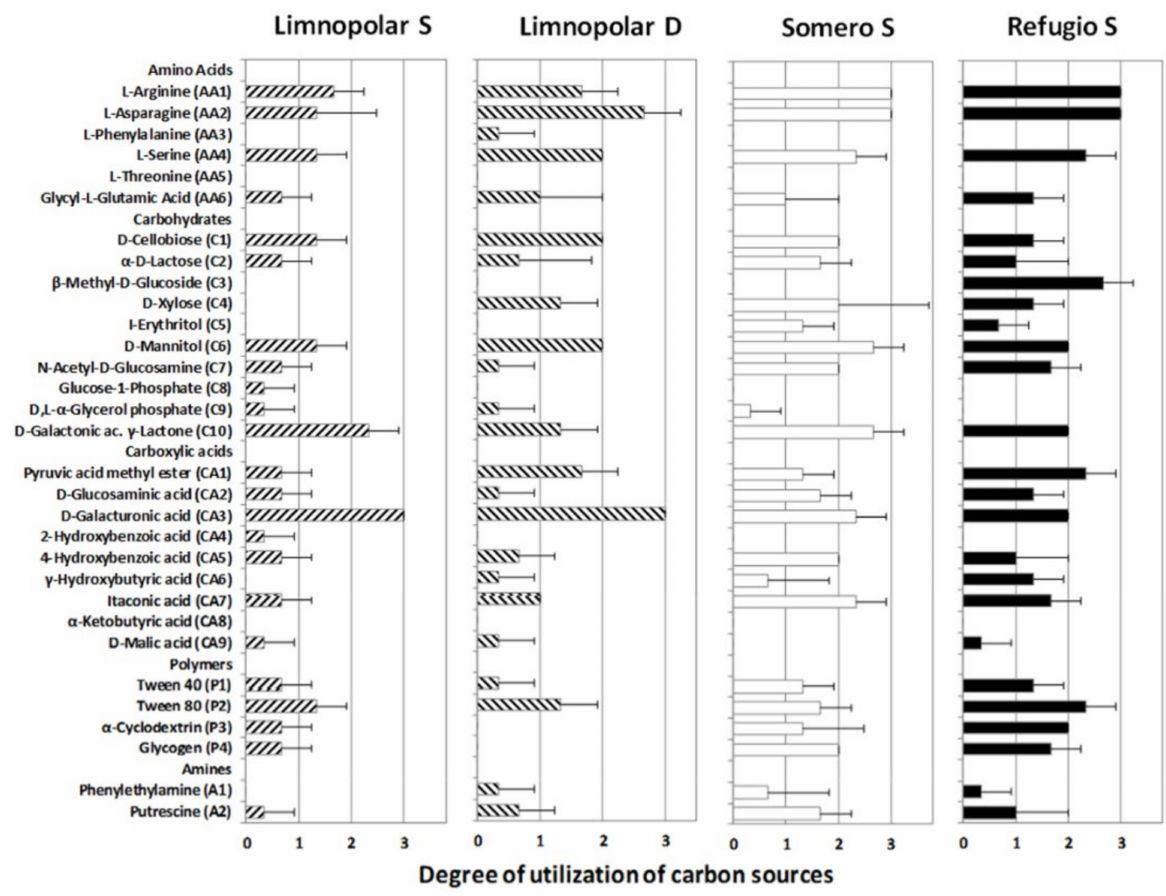
Figure 5. Carbon sources’ average utilization profiles (Biolog Ecoplates) for samples of Lake Limnopolar (S = surface and D = Deep waters), and surface waters of the shallow lakes Somero and